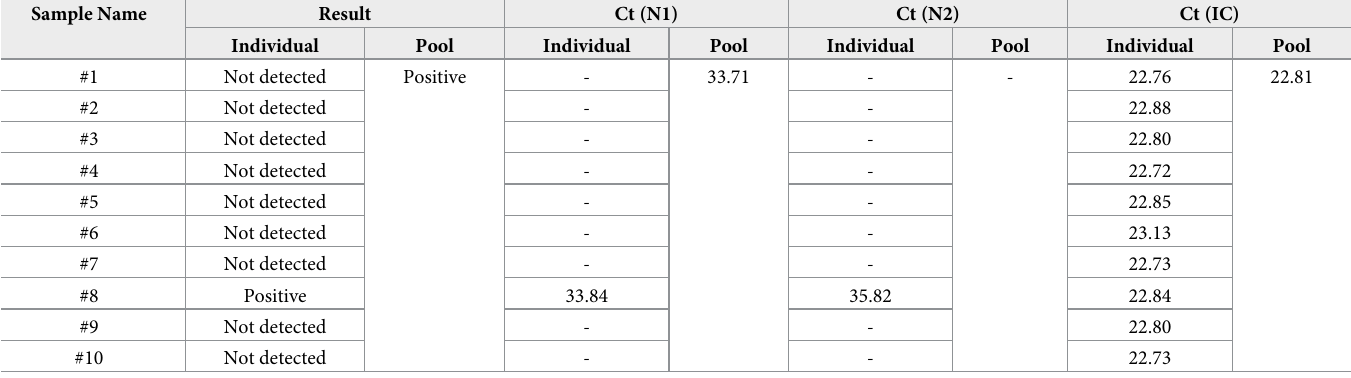
Table 1. Individual amplification of 10 samples from the pool including positive case 1